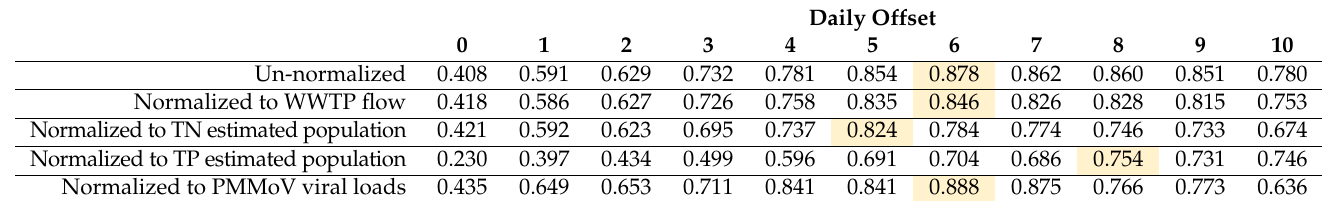
Table 2. Time-shifted analyses of the Pearson correlation coefficients (r) at RAN WWTP between un-normalized as well as normalized SARS-CoV-2, and the 7-day rolling averages of clinical cases offset over a time period of 1–10 days (where 0 refers to the wastewater sample collection date). Daily Offset 0 Un-normalized